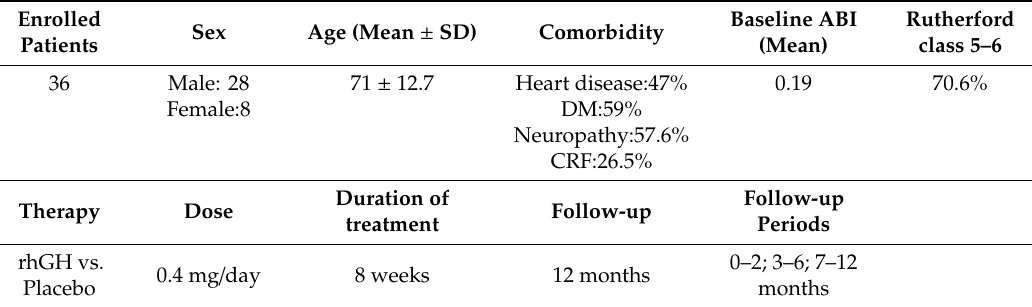
Table 1. Main characteristics of the patients recruited in the GHAS trial. Enrolled patients: patients with informed consent; age: years old ± standard deviation; ABI: ankle–brachial index; CRF: